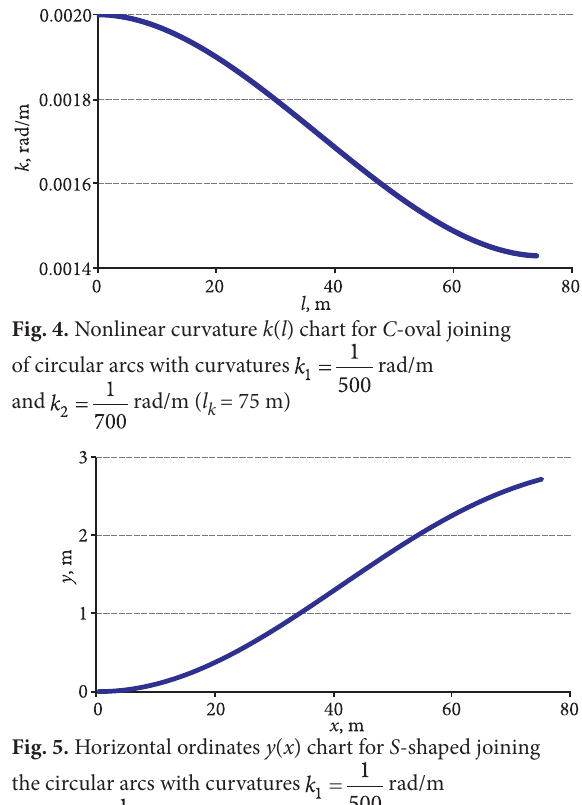
Fig. 5. Horizontal ordinates y ( x ) chart for S -shaped joining the circular arcs with curvatures rad/m and rad/m ( l k = 75